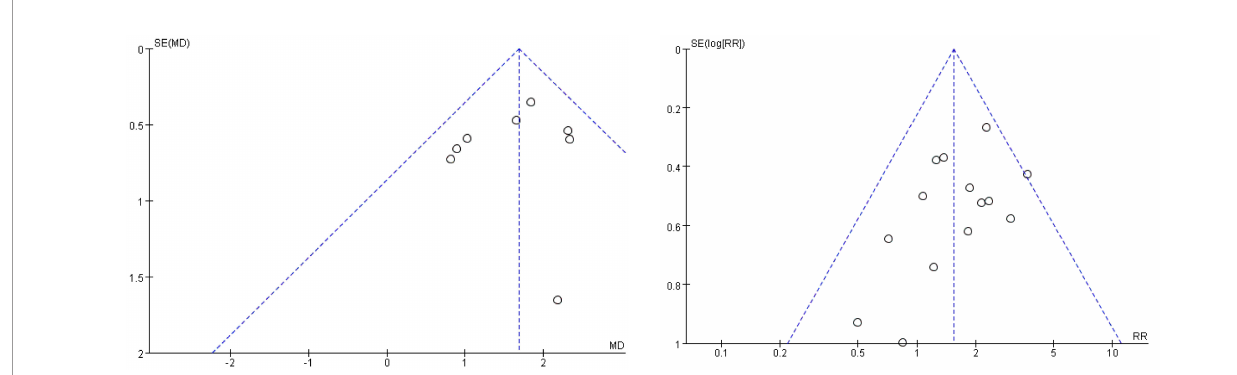
FIGURE 8 | Funnel plot of endometrial thickness and pregnancy rate.